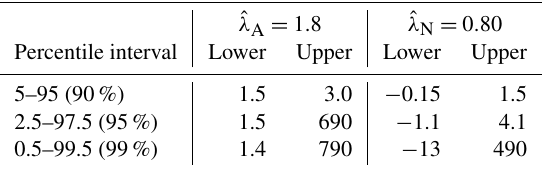
Table 1. Parametric bootstrap percentile intervals for the sensitivi- ties in model (4), λ A and λ N , to anthropogenic and natural sources, respectively (in units ◦ C per doubling). The data appear to provide a lower bound for λ A , but cannot rule out even implausibly large val- ues; the very large values are associated with slow responses (see Fig. 4). The data cannot rule out λ N = 0, likely because there are few prominent volcanic eruptions in the historical record analyzed and the response to volcanic aerosols may be small. ˆ λ = 1 . 8 ˆ λ N = 0 . 80 A